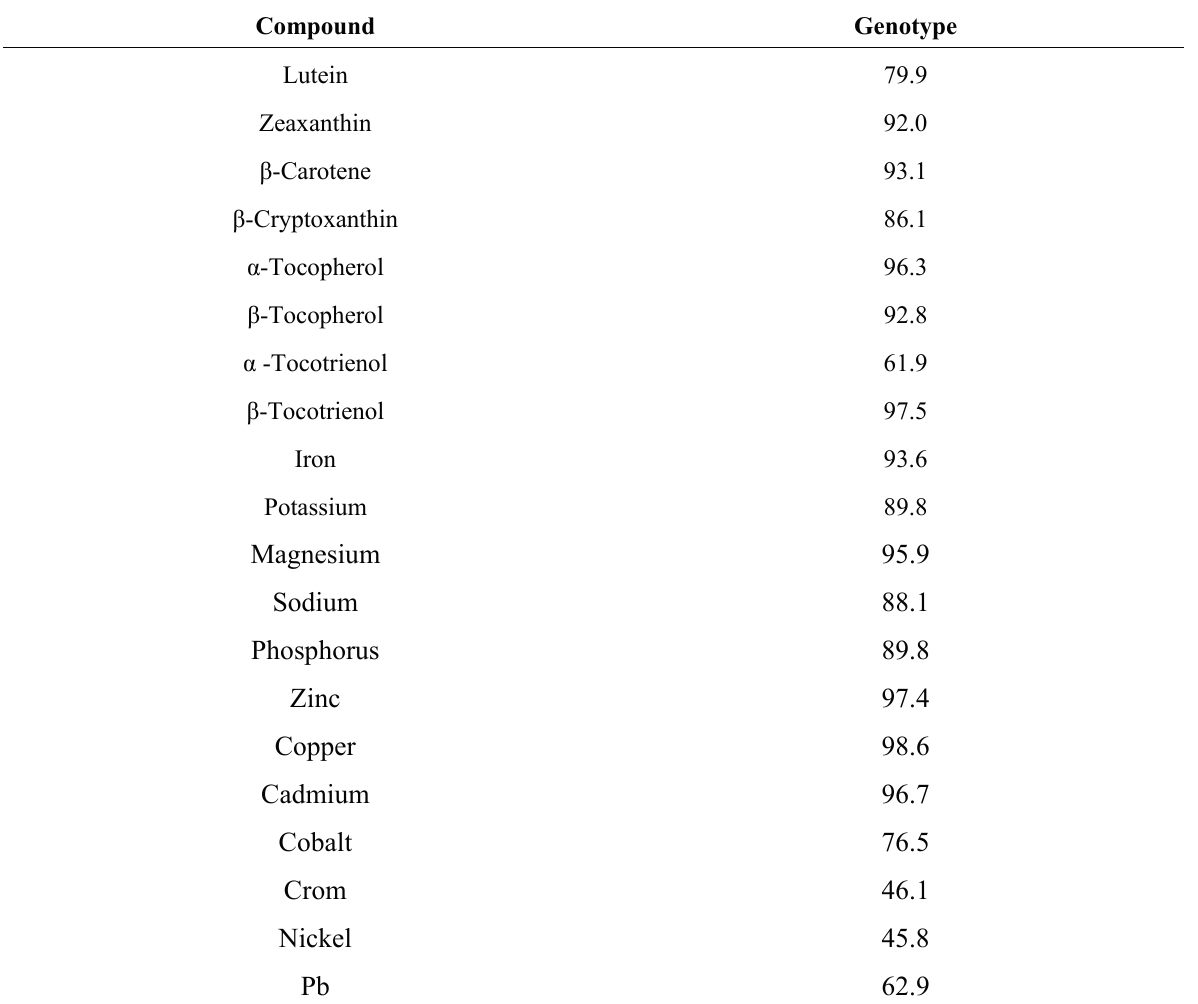
Table 5. Percentage of explanation (obtained through R-square from simple linear regression) of the evaluated compounds on ranked